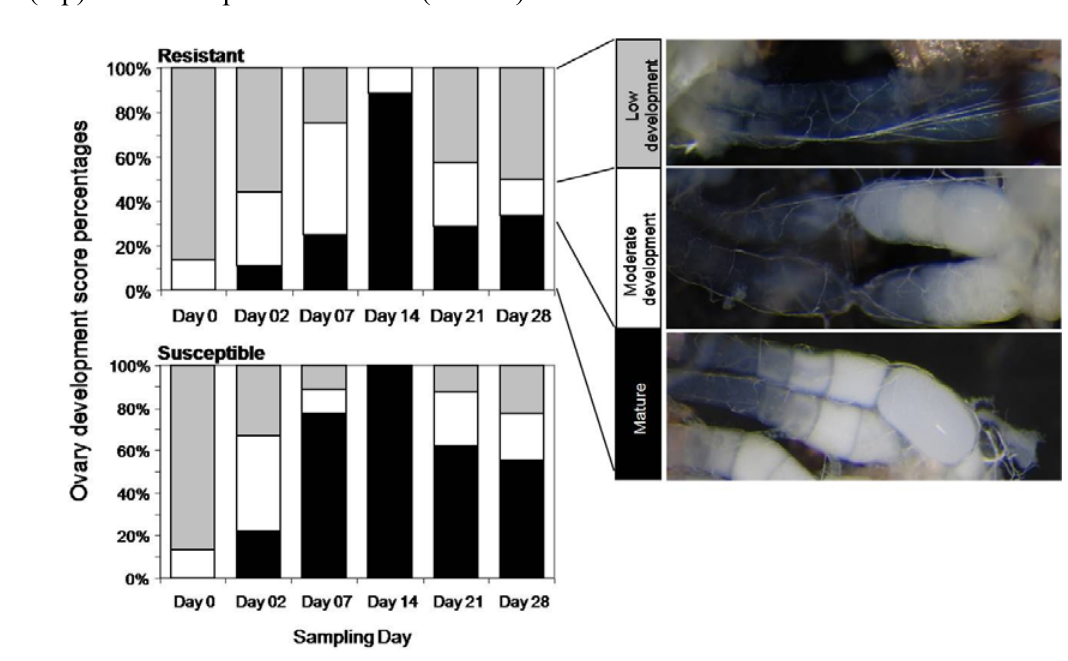
Figure 4. Weevil ovary development on resistant and susceptible tree genotypes. The percentage weevils with low (gray bars), moderate (white bars), or mature (black bars) ovary development for each sampling day. Weevils were restricted to either resistant host trees (top) or to susceptible host trees